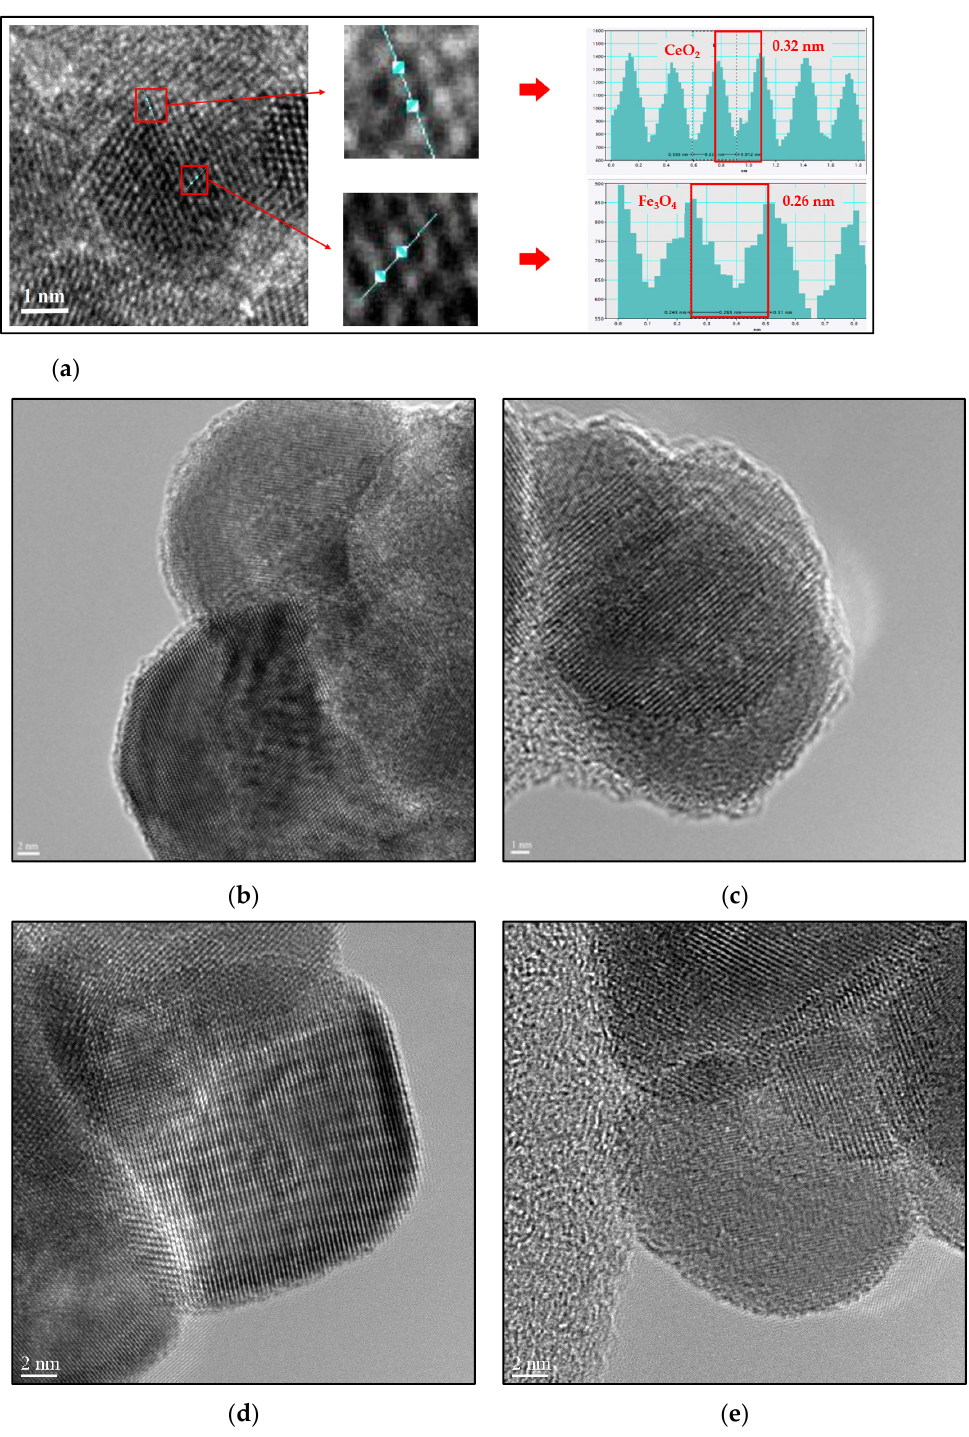
Figure 4. ( a ) Field Emission Transmission Electron Microscope (FE-TEM) images and lattice fringe spacing of Fe 3 O 4 @CeO 2 ; ( b , c ) FE-TEM images for confirmation of coated HA of Fe 3 O 4 @CeO 2 -APTES-HA nanoparticles and ( d , e ) Fe 3 O 4 @CeO 2 trying to coat hyaluronic acid